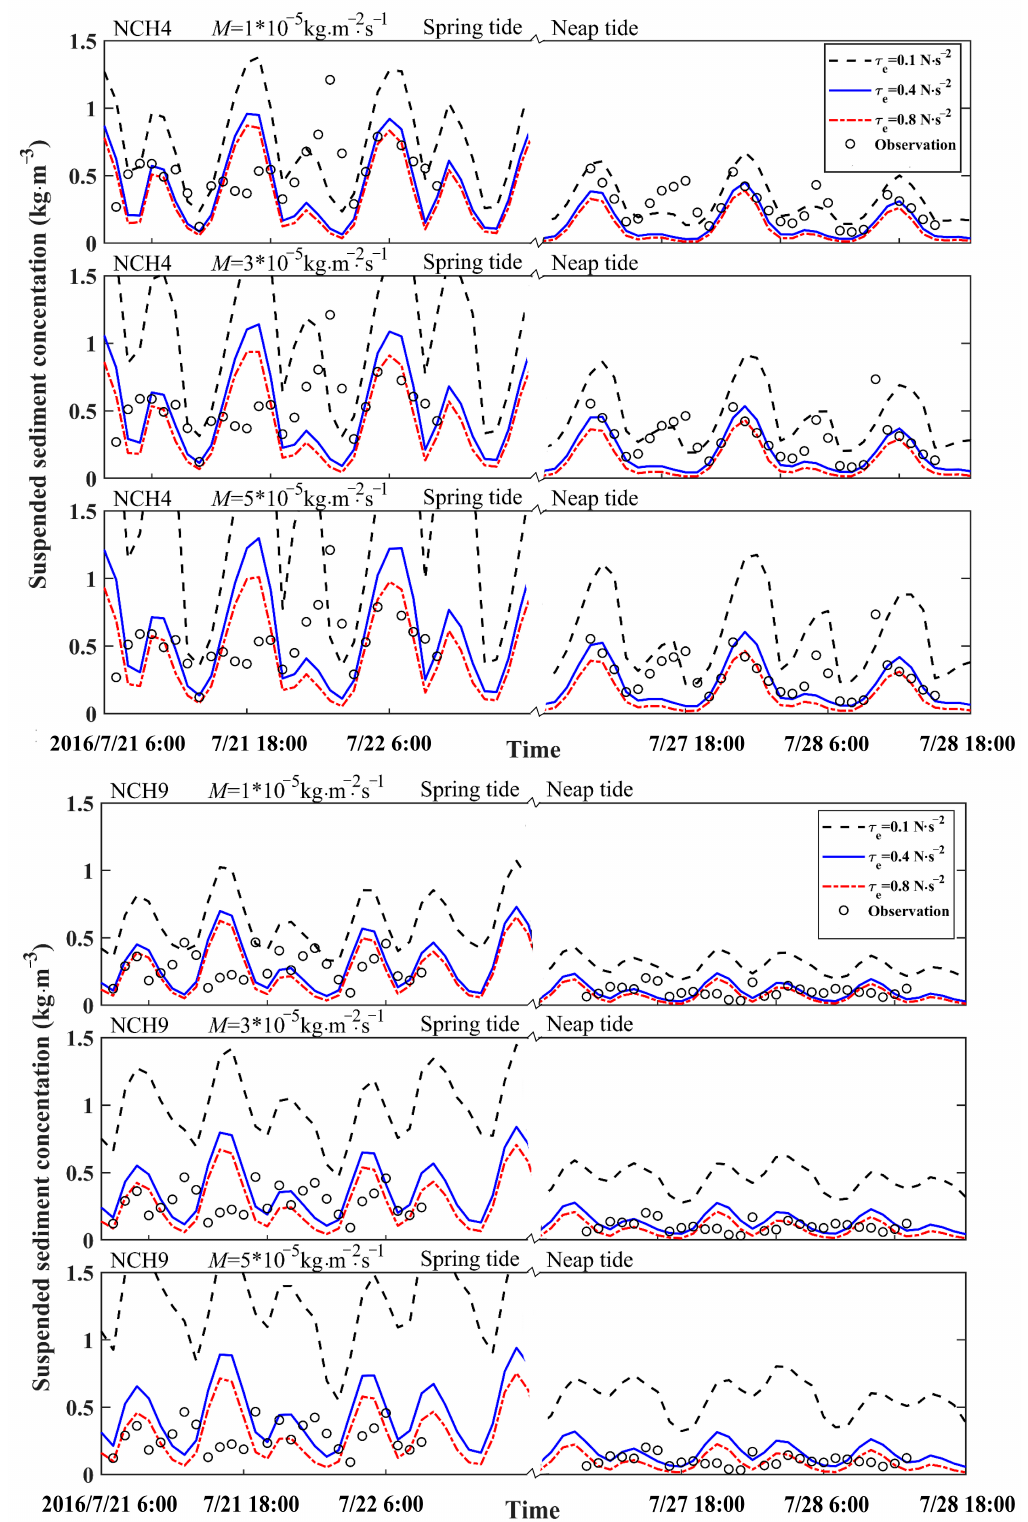
Figure 9. Comparison of simulated and measured SSC under the different critical shear stresses and erosion coefficients at 8 stations shown in Figure 3b. The graphs on the left and right sides of break-line symbol show the variation of SSC during spring tide and neap tide, respectively.